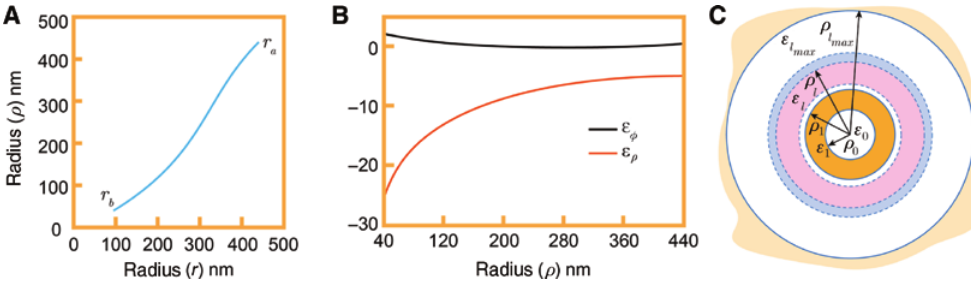
Figure 2: Details of the transformation optics design. (A) Schematic figure of the transformation function for r focusing device. (C) Schematic configuration of an approximate layered